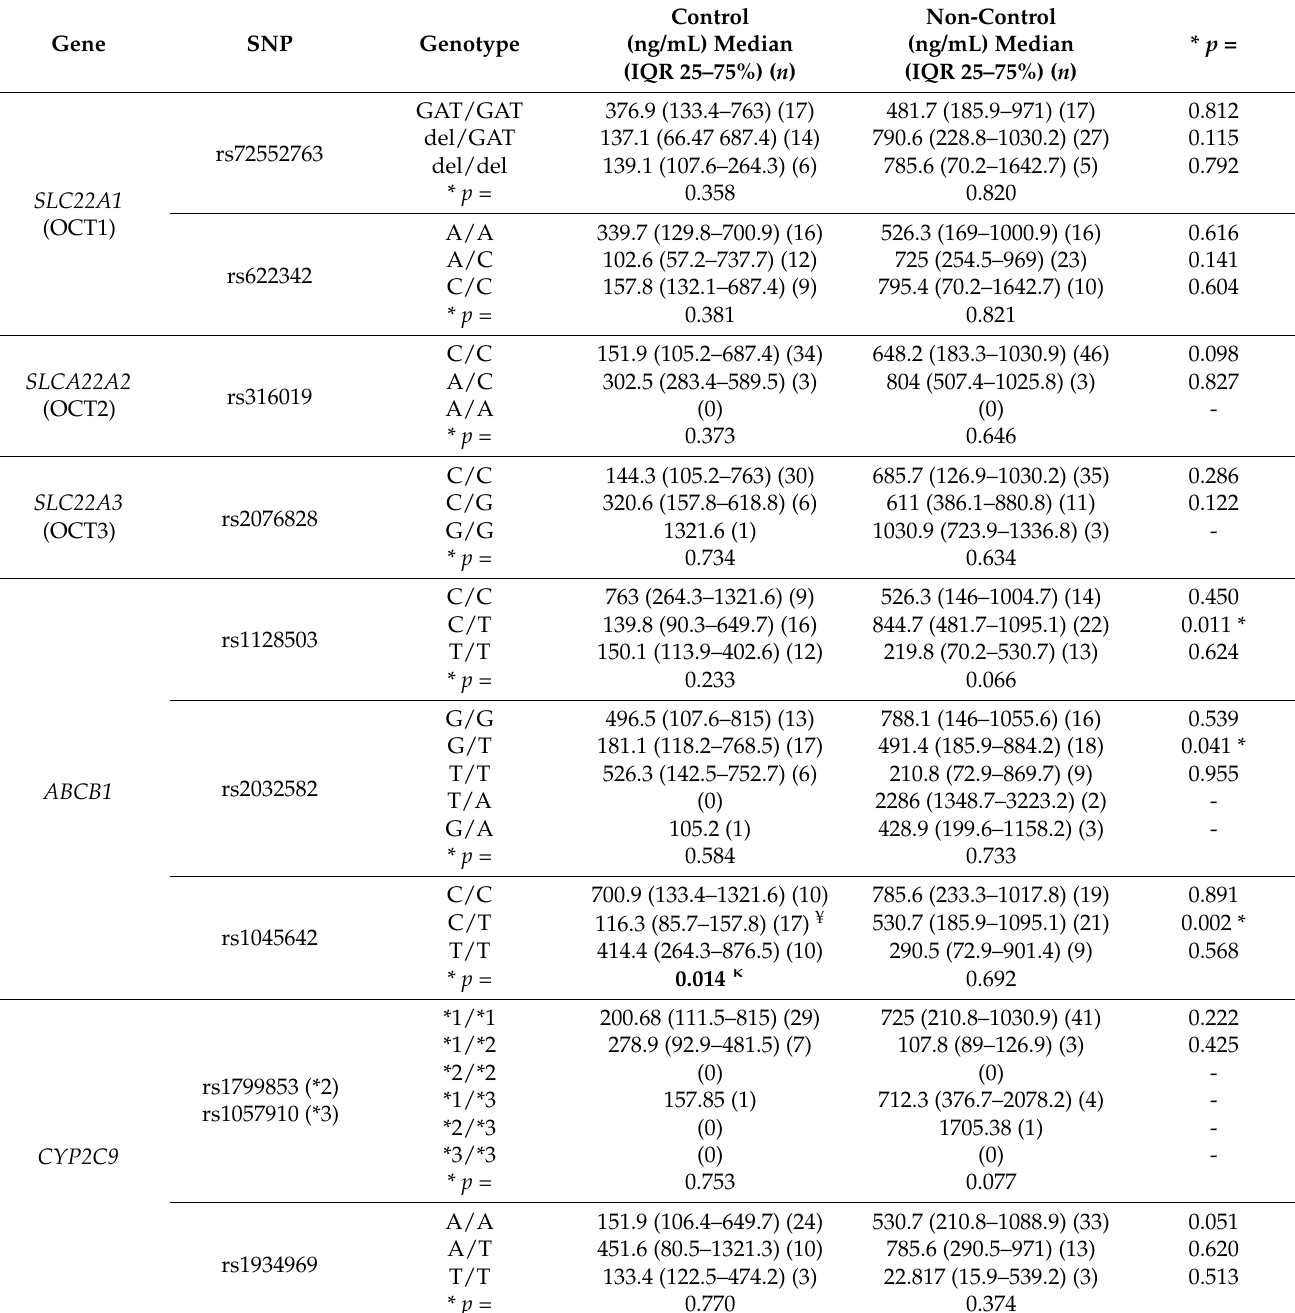
Table 4. Metformin plasmatic concentrations among DMT2 patients grouped by SNP and